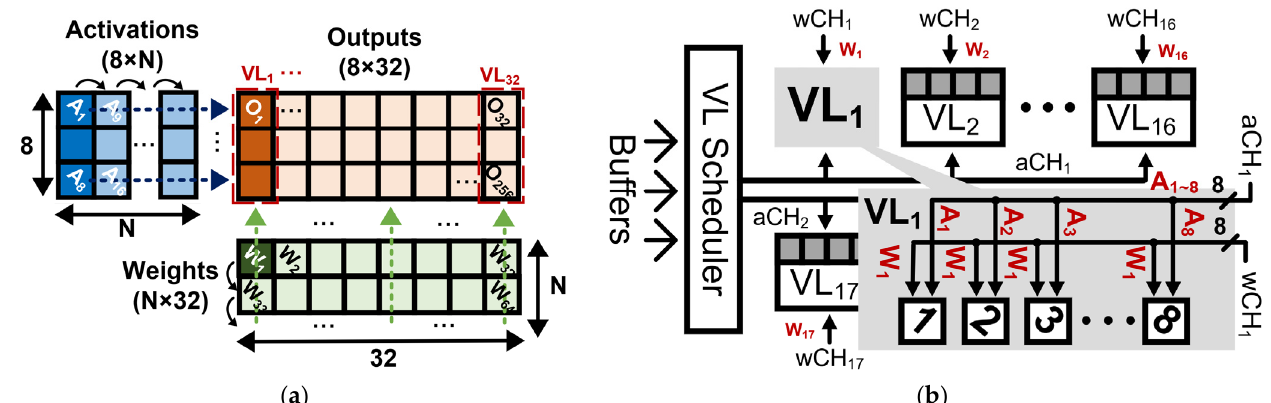
Figure 8. Example of matrix multiplication between 8 × N activations and N × 32 weights inside CONNA: ( a ) 8 × 32 matrix multiplication and ( b ) matrix multiplication conducted in CONNA.